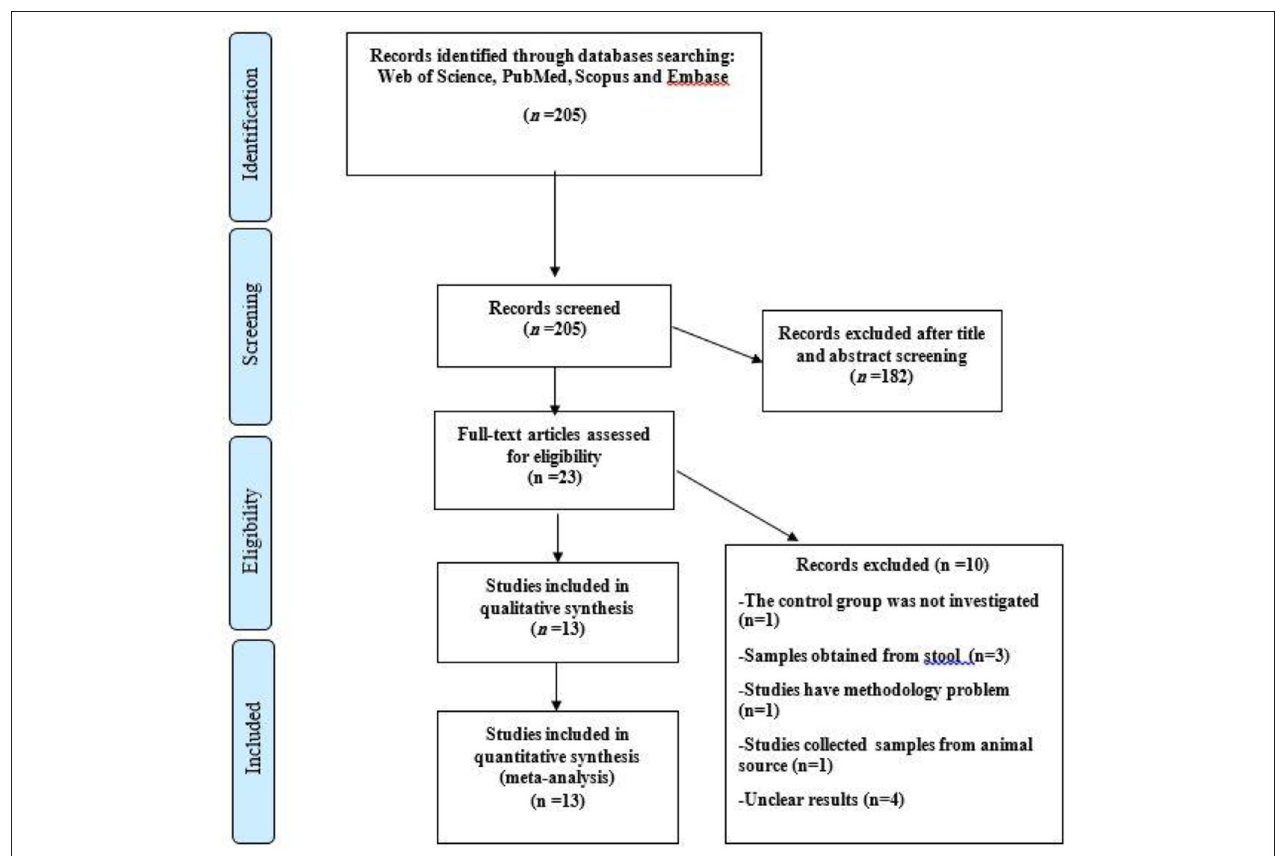
FIGURE 1 | Flow chart of the study selection for inclusion in the systematic